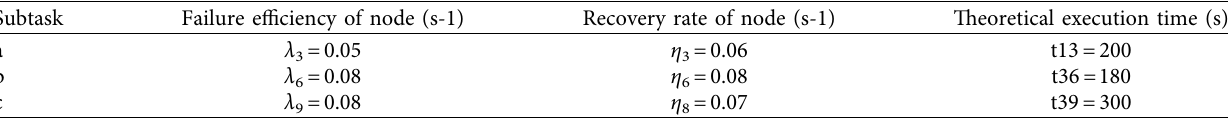
Table 1: Node parameter calculation